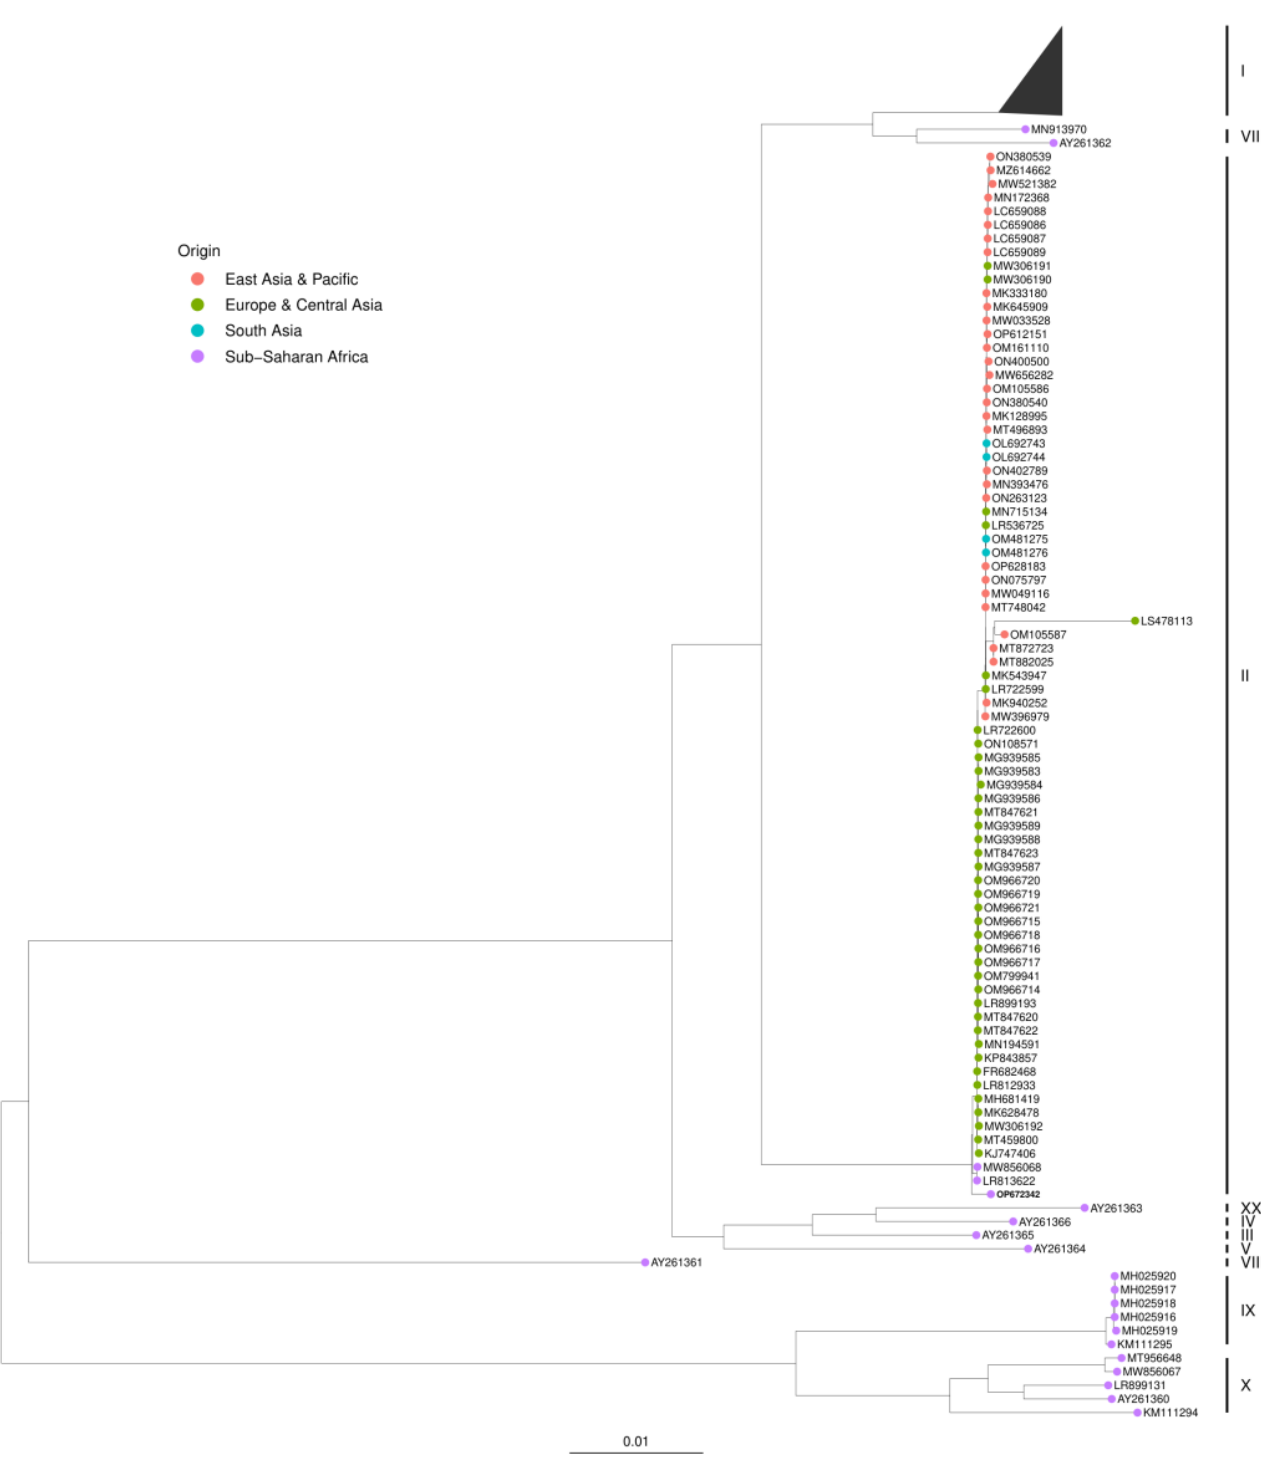
Figure 3. Maximum-likelihood (ML) phylogenetic tree of 162 ASFV whole genome sequences. Se- quences were aligned in MAFFT 7.505 with 1000 bootstrap followed by phylogenetic tree construction using the IQ-TREE. The phylogenetic tree was then visualized using ggtree. The 2020 and 2019 ASFV Nigerian strains sequenced are represented in blue. For clarity, only a limited number of ASFV p72 genotypes are depicted. All sequences belonged to Genotype I are collapsed, the sequences representing different countries are color coded, and the ASFV RV502 sequence (OP672342) is in bold.